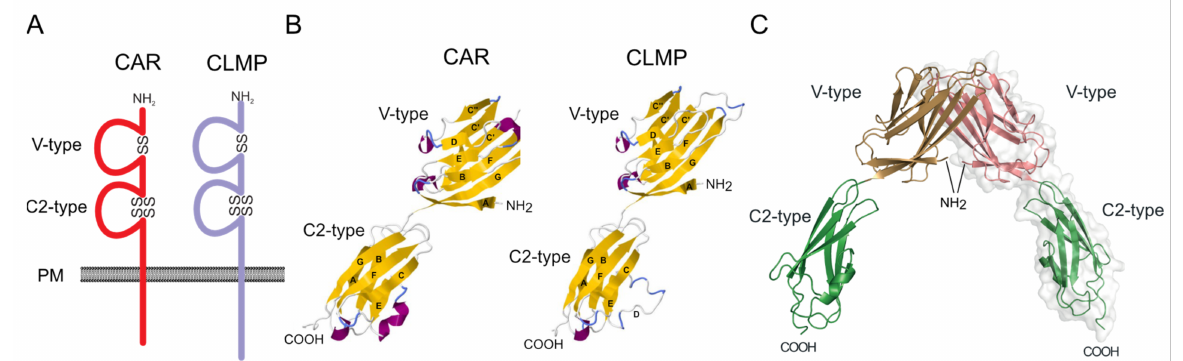
Figure 2. ( A ) Scheme of CLMP and CAR. Ig domains are indicated as loops. Disulfide bridges between β -sheets of Ig-domains are depicted by SS. ( B ) Crystal structure of the extracellular region of CAR at a 2.19 Å resolution (PDB: 3jz7A) [21,22] which was used to calculate the CLMP protein tertiary structure by Phyre2 [24]. β -strands in the N-terminal and C-terminal domain are labelled in uppercase letters. ( C ) Two symmetry-related mCAR monomers form a U-shaped dimer via their N-terminal domains. This dimer formation might also be predicted for